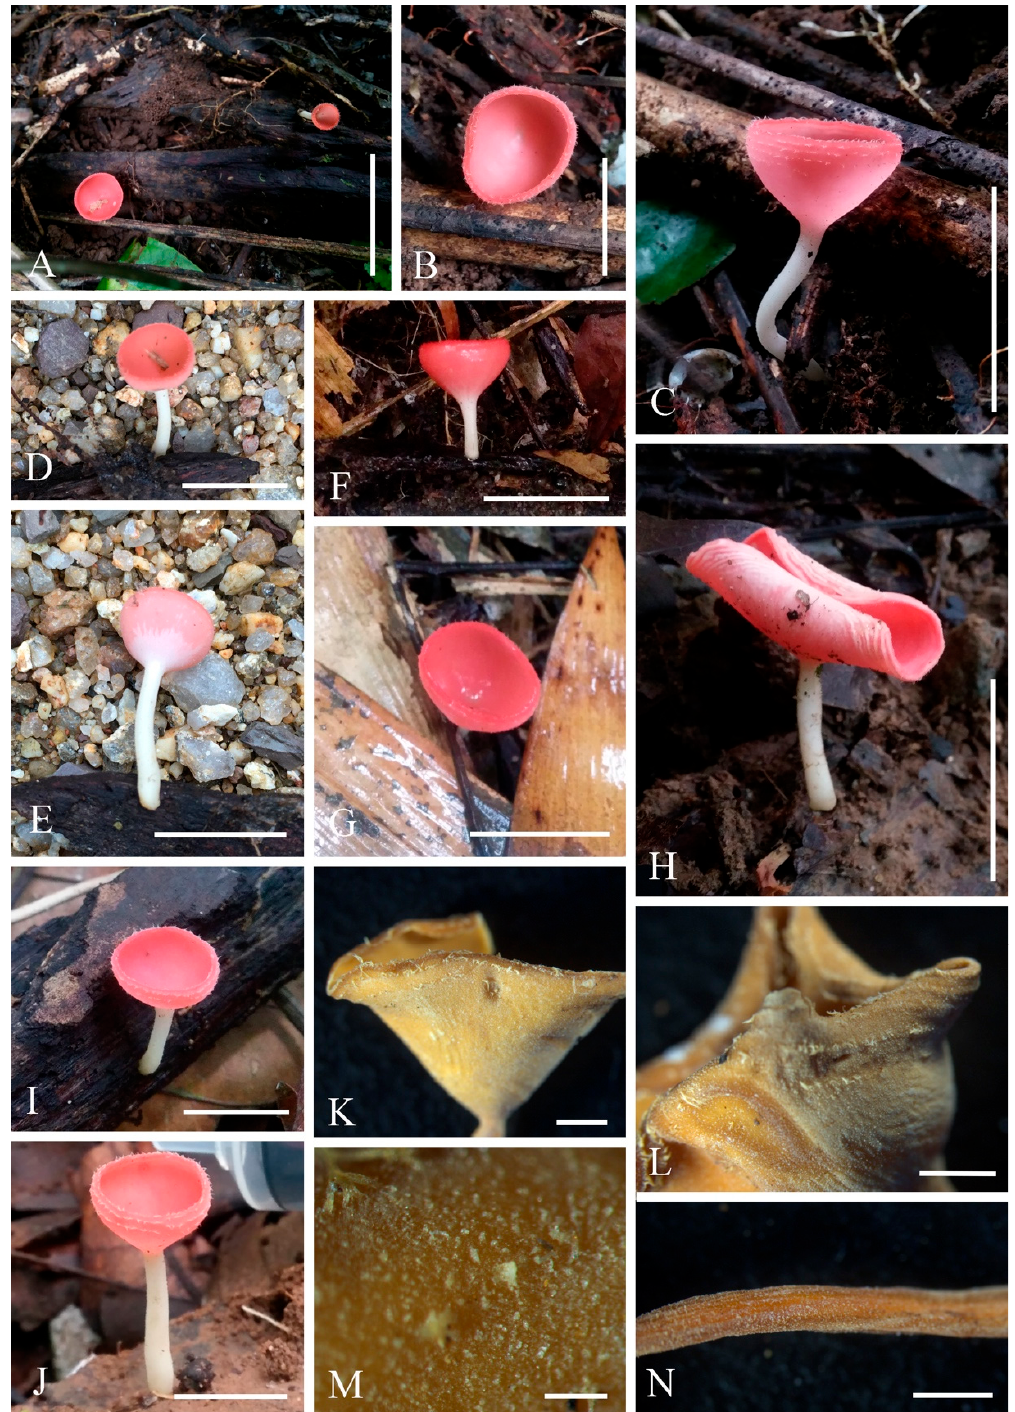
Figure 9. Cookeina speciosa . ( A – J ) Fresh apothecia [( A – C ) MFLU 21 ‐ 0158. ( D , E ) MFLU 21 ‐ 0162. ( F , G ) MFLU 21 ‐ 0156. ( H ) MFLU 21 ‐ 0159. ( I ) MFLU 21 ‐ 0161. ( J ) MFLU 21 ‐ 0160. ( K ) Dry apothecium (MFLU 21 ‐ 0160). ( M ) Receptacle surface of an apothecium (MFLU 21 ‐ 0160). ( L ) Hairs are arranged in concentric ridges (MFLU 21 ‐ 0158). ( N ) Stipe (MFLU 21 ‐ 0158). Scale bars ( A ) = 5 cm; ( B , D – G , I , J ) = 2 cm; ( C , H ) = 3 cm; ( K , L , N ) = 2000 μ m; ( M ) = 300 μ m.